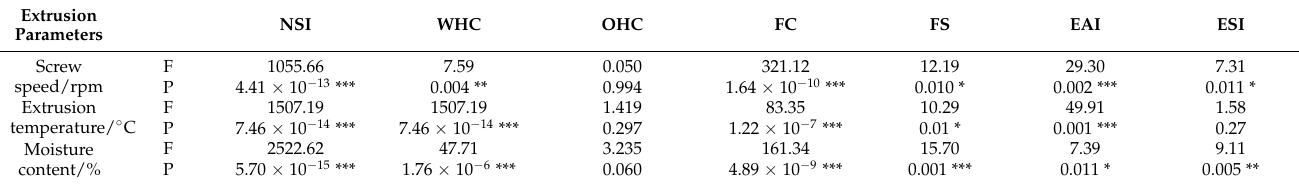
Table 3. One-way ANVOA analysis of the functional properties of textured rice